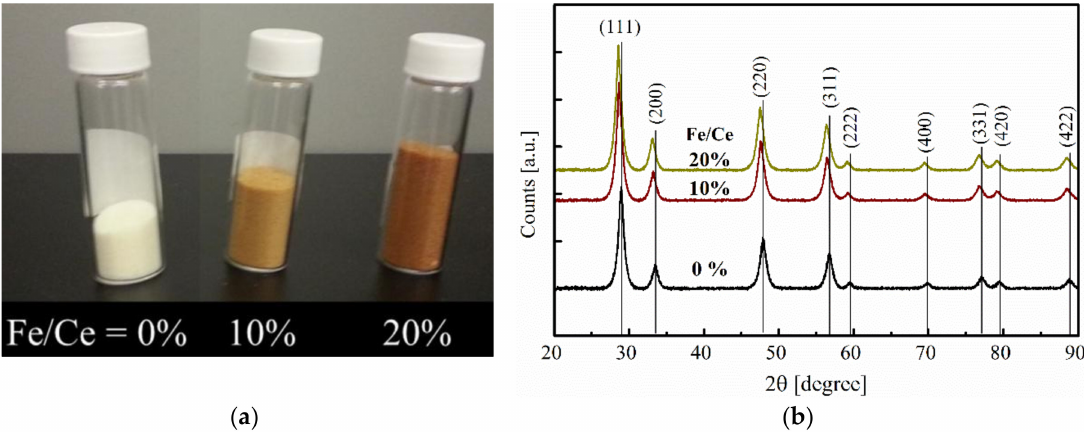
Figure 1. ( a ) Direct images of pure and iron-doped cerium oxide nanoparticles; ( b ) XRD patterns of iron-doped cerium oxide nanoparticles (10% and 20%) compared to the pure cerium oxide nanoparticles